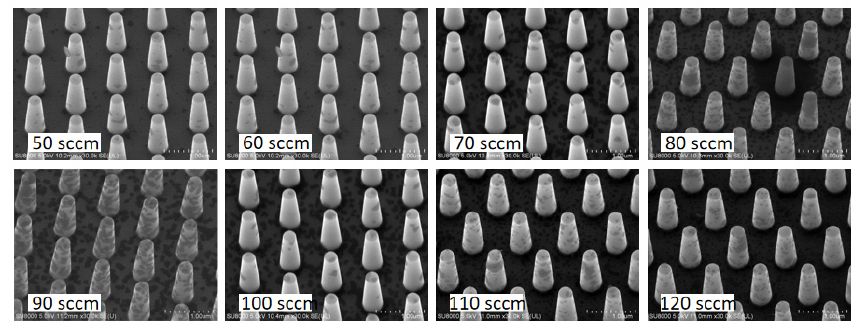
Figure 3. Effect of the carrier gas flow rate on the 2D MoS2 crystal size and encapsulation rate.